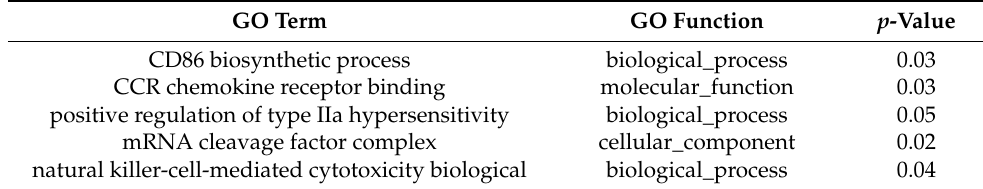
Table 2. Co-enriched GO terms of DE lncRNA and DE